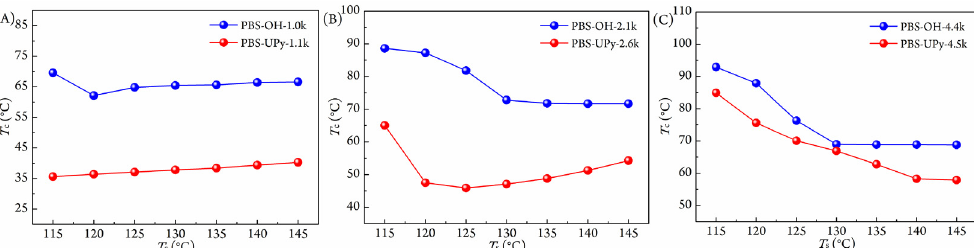
Figure 9. T s – T c curves of PBS-OH-1.0k and PBS-UPy-1.1k ( A ), PBS-OH-2.1k and PBS-UPy-2.6k ( B ) and PBS-OH-4.4k and PBS-UPy-4.5k ( C ).